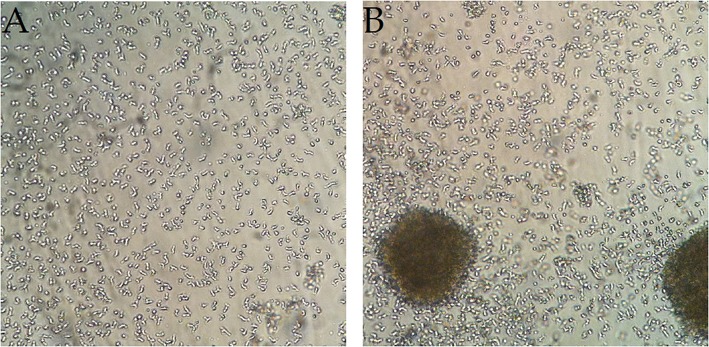
Homotypic cell clusters form on the non-adherent surface but less on the standard culture dish. Representative microscopy pictures of iDC (DMSO) at the end of the 3-day culture on (A) a standard cell culture dish and (B) a non-adherent culture dish. The increase in cell cluster formation on non-adherent dishes relative to standard dishes could be observed for all treatments (n = 8).